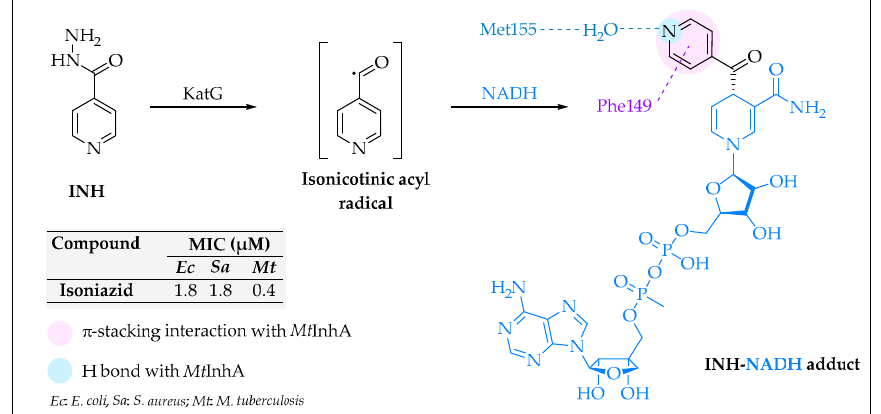
Figure 30. Structure, representation of the main interactions with Mt InhA and in vitro activities of INH and its active form bound to NADH [7,47,126].